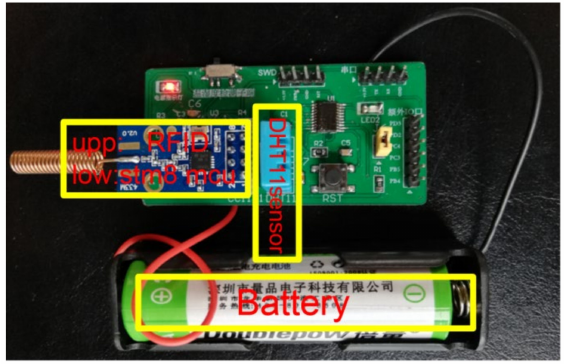
Figure 3. Sensor node physical